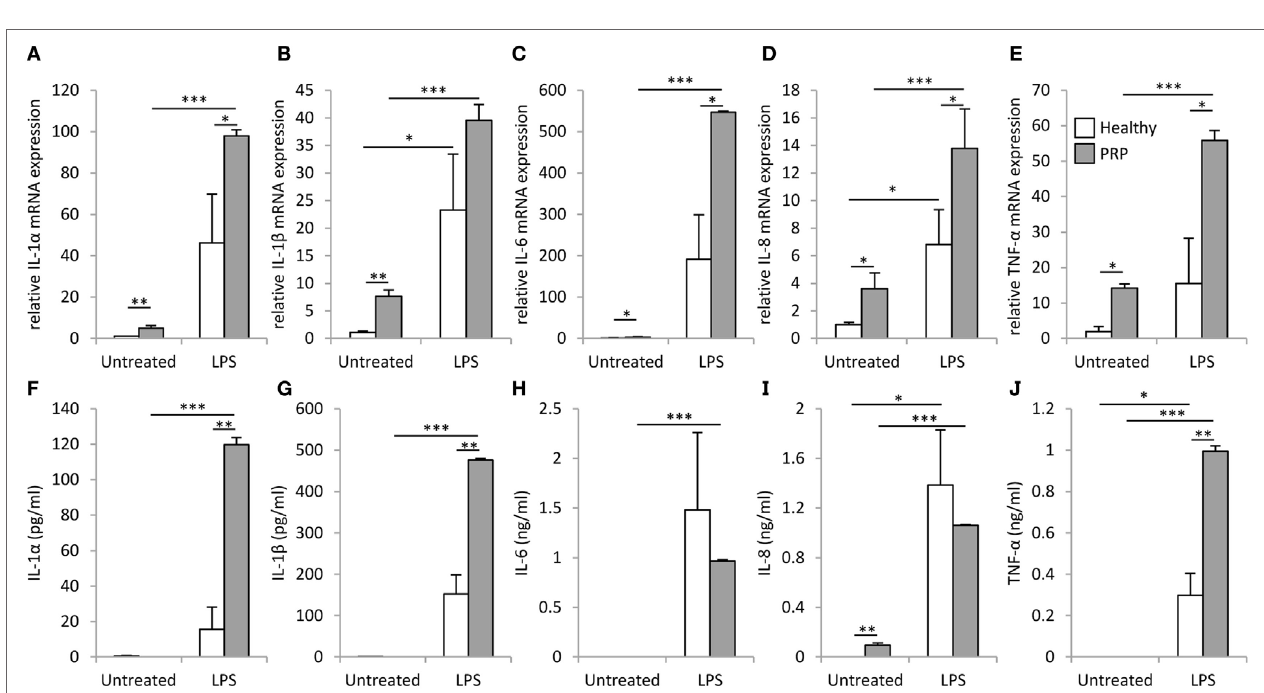
FIgURe 4 | mRNA expression and secretion of inflammatory cytokines in peripheral blood mononuclear cells (PBMCs). IL­1 α (a) , IL­1 β (B) , IL­6 (C) , IL­8 (D) , and tumor necrosis factor (TNF)­ α (e) mRNAs were detected in PBMCs derived from healthy (white) or Pityriasis rubra pilaris (PRP) (gray) cells 6 h after treatment with 100 ng/ml LPS. Secretion of IL­1 α (F) , IL­1 β (g) , IL­6 (H) , IL­8 (I) , and TNF­ α (J) was detected for PBMCs derived from a healthy individuals (white, n = 3) or the PRP patient (gray, n = 1) 6 h after treatment with 100 ng/ml LPS. Data are represented as mean ± SE; statistical significance was determined by ANOVA * p < 0.05; ** p < 0.01; and *** p < 0.001.